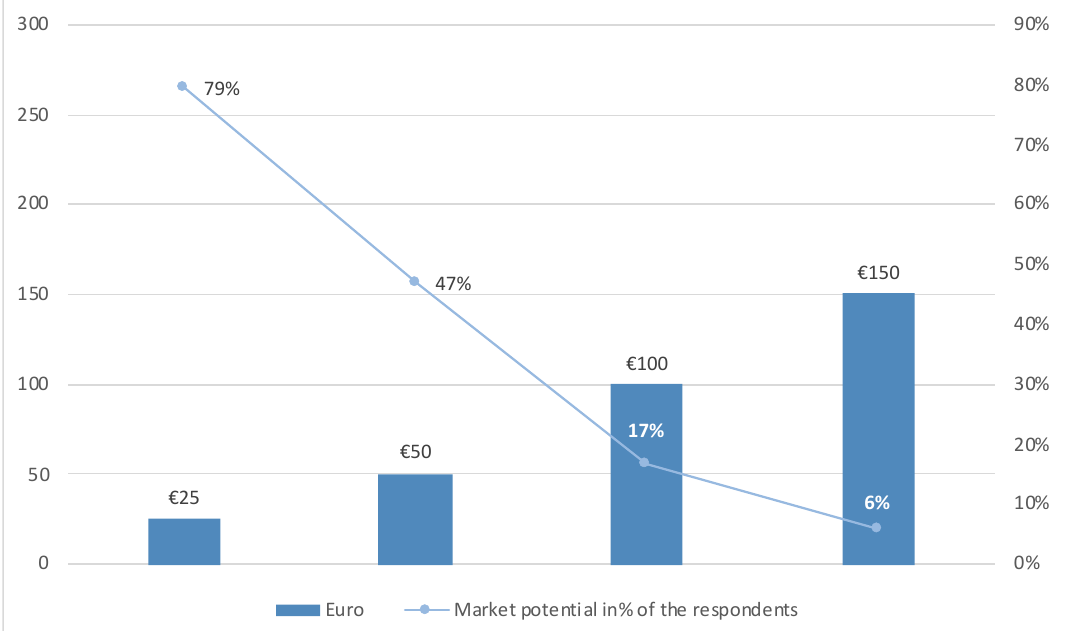
Figure 3. Direct WTP and market potential for MaaS